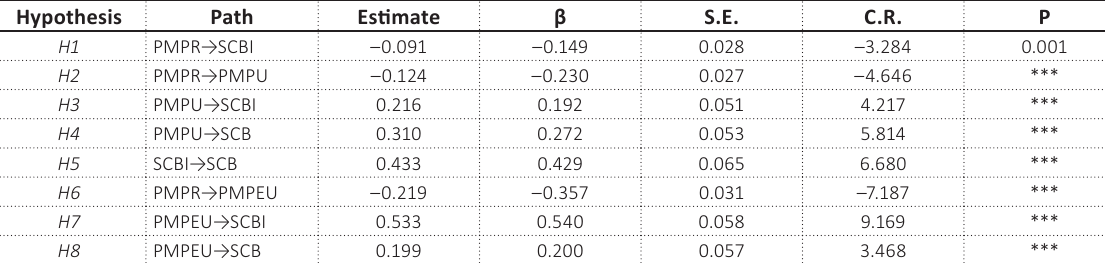
Table 7. Path analysis of structural equation model